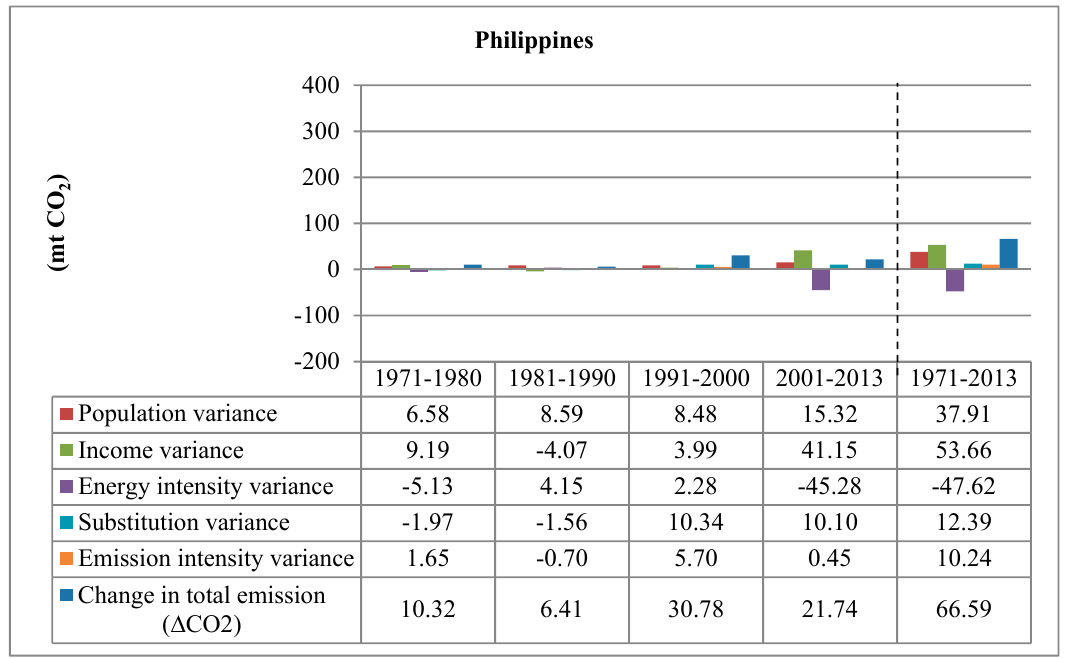
Figure 12. Decomposition results of CO 2 emissions in Philippines.